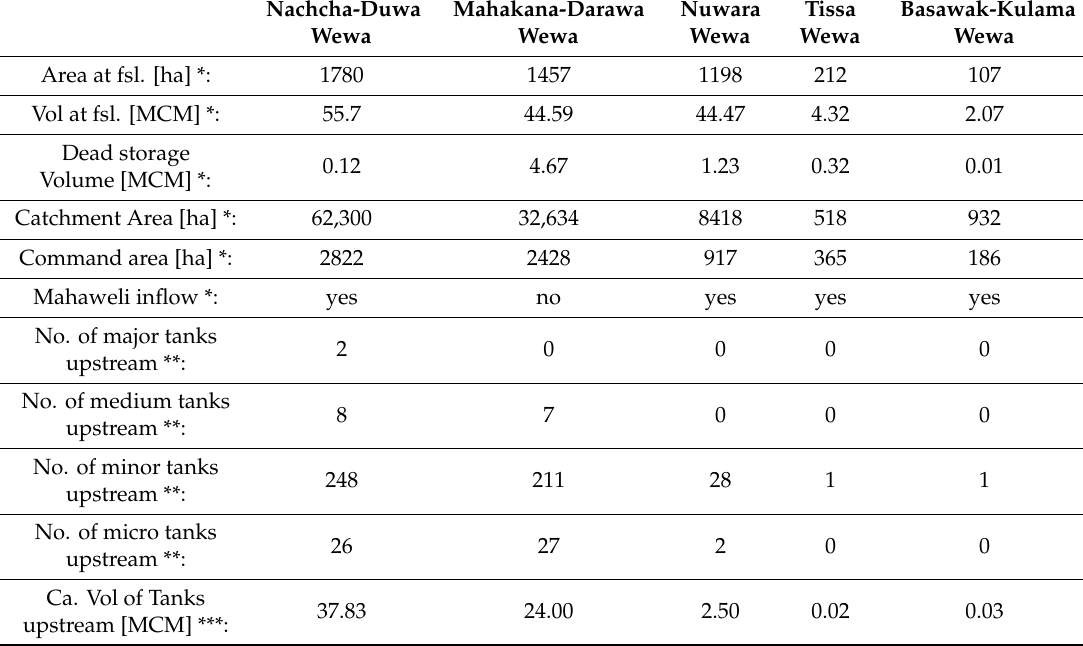
Table 1. Basic information for the five tanks of interest (MCM = million cubic meter, fsl. = full support